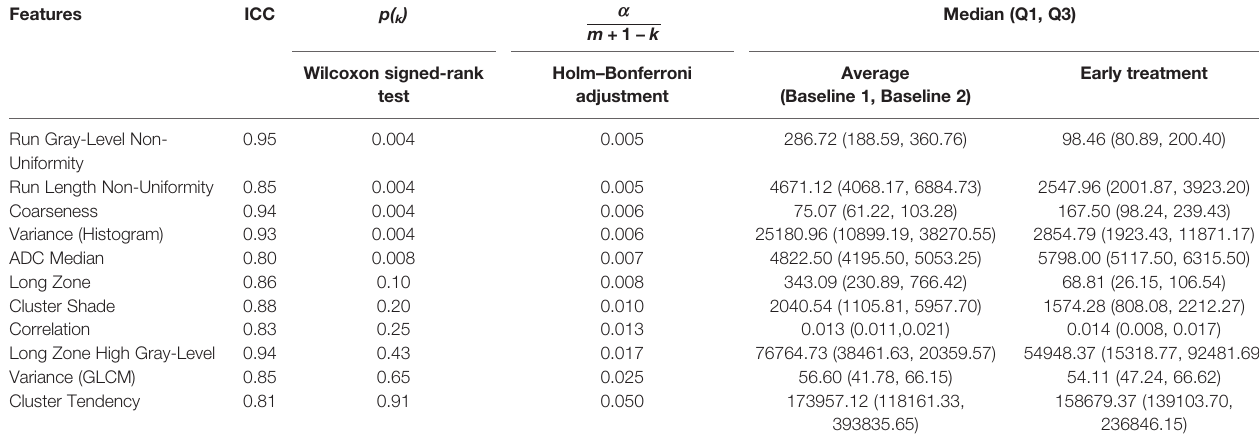
TABLE 4 | Results of the Holm – Bonferroni-corrected Wilcoxon signed-rank test between the average baselines 1 and 2 and early treatment histogram and texture features. Features